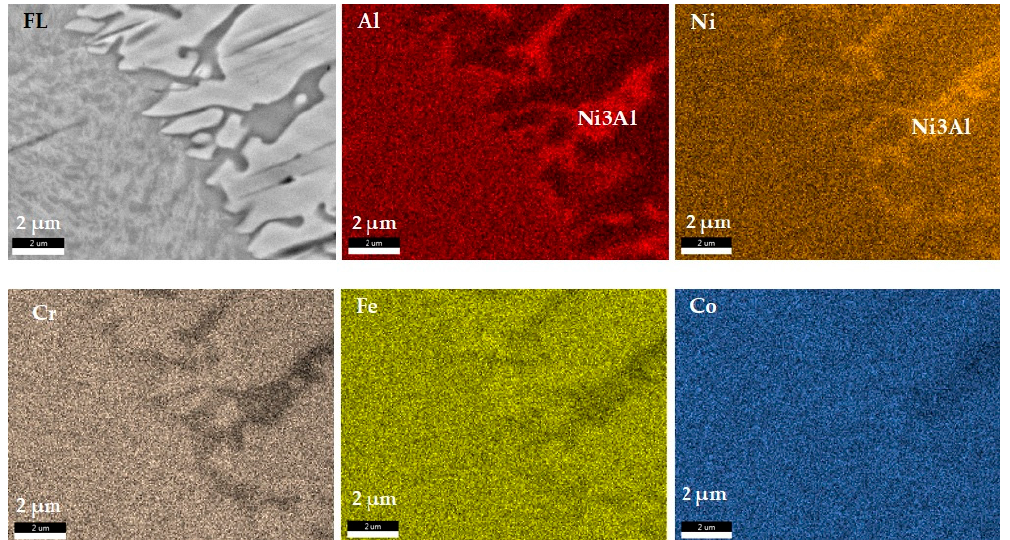
Figure 6. Elements distribution maps on fusion line between HEA and weld deposit.